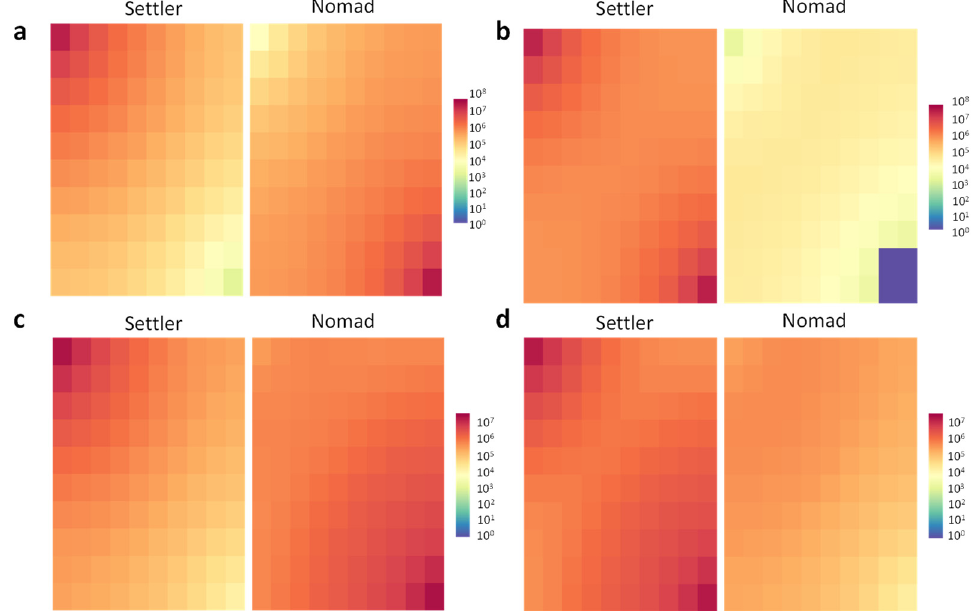
Figure 4. The effect of the migration penalty fee value on the spatial dispersion of Settler and Nomad cells in the habitat (the snapshots are taken at the end of the simulation run under quadratic mortality, the results under linear mortality does not differ significantly). Heatmap scale represents the abundance measured in the number of cells. The “start” nutrient source is located in the upper-left corner while the “distant” source is located in the opposite bottom-right corner. One can see that as the energetic costs of migration increases, the dominance switch occurs in the following cases—turning from scenario with nutrient concentration in a batch equal to 1 × 10 − 5 M and penalty fee value equal to 2% ( a ) to the scenario with the same nutrient concentration in a batch but higher penalty fee value equal to 5% ( b ), and turning from scenario with nutrient concentration in a batch equal to 1 × 10 − 6 M and penalty fee value equal to 5% ( c ) to the scenario with the same nutrient concentration in a batch but higher penalty fee value equal to 10% ( d ).